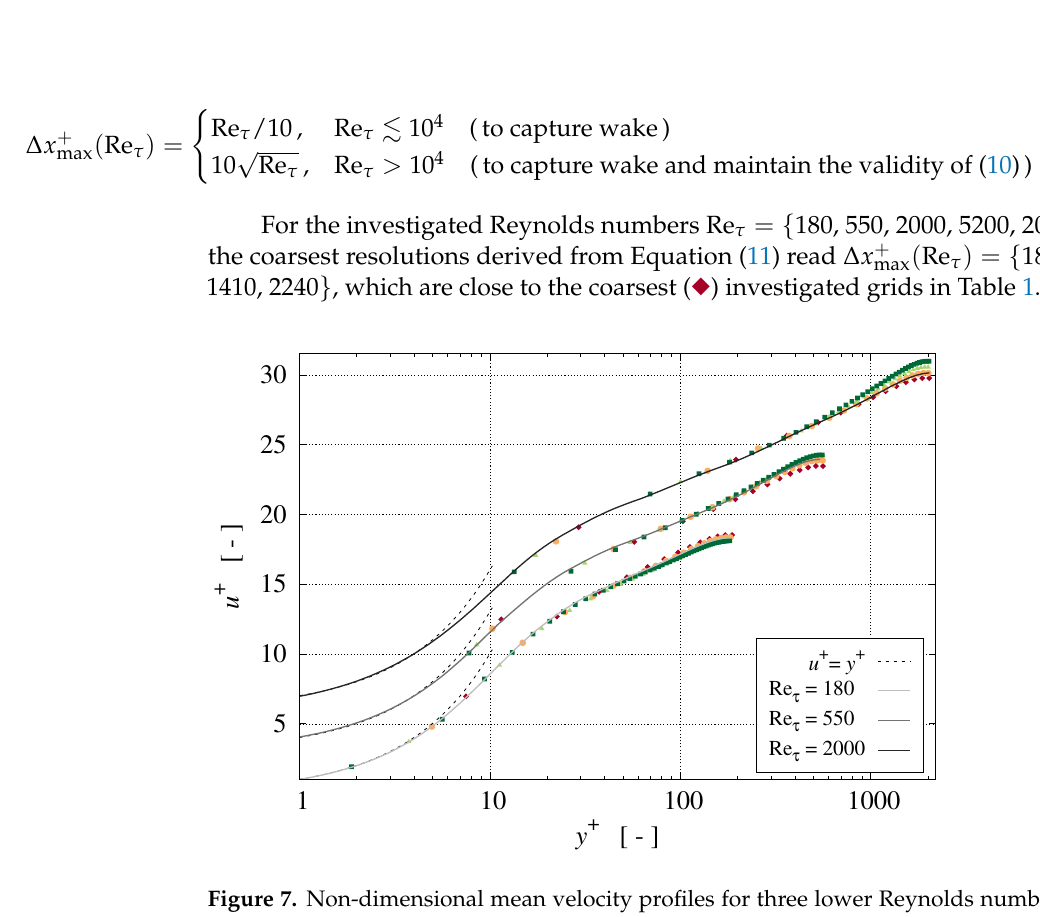
Figure 7. Non-dimensional mean velocity profiles for three lower Reynolds numbers. Solid lines refer to reconstructions of discrete reference data sets published by Kim et al. [31] for Re τ = 180 and Bernardini et al. [32] for Re τ = { 550, 2000 } as given in Gehrke and Rung [27]. The color codes of the symbols are given in Table 1. To improve the comparison, the profile for Re τ = 550 [ 2000 ] is vertically shifted by ∆ u + = 3 [ 6 ] .